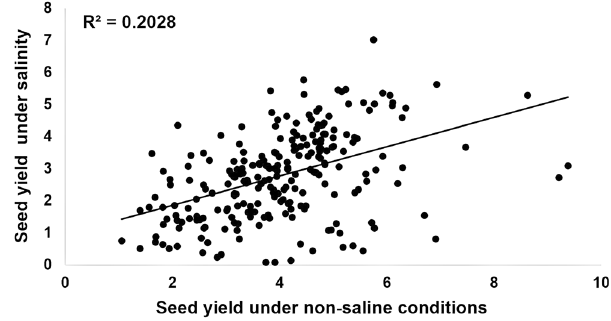
Figure 4. Relationship between seed yield in non-saline and seed yield under salinity. Level of significance ** p <